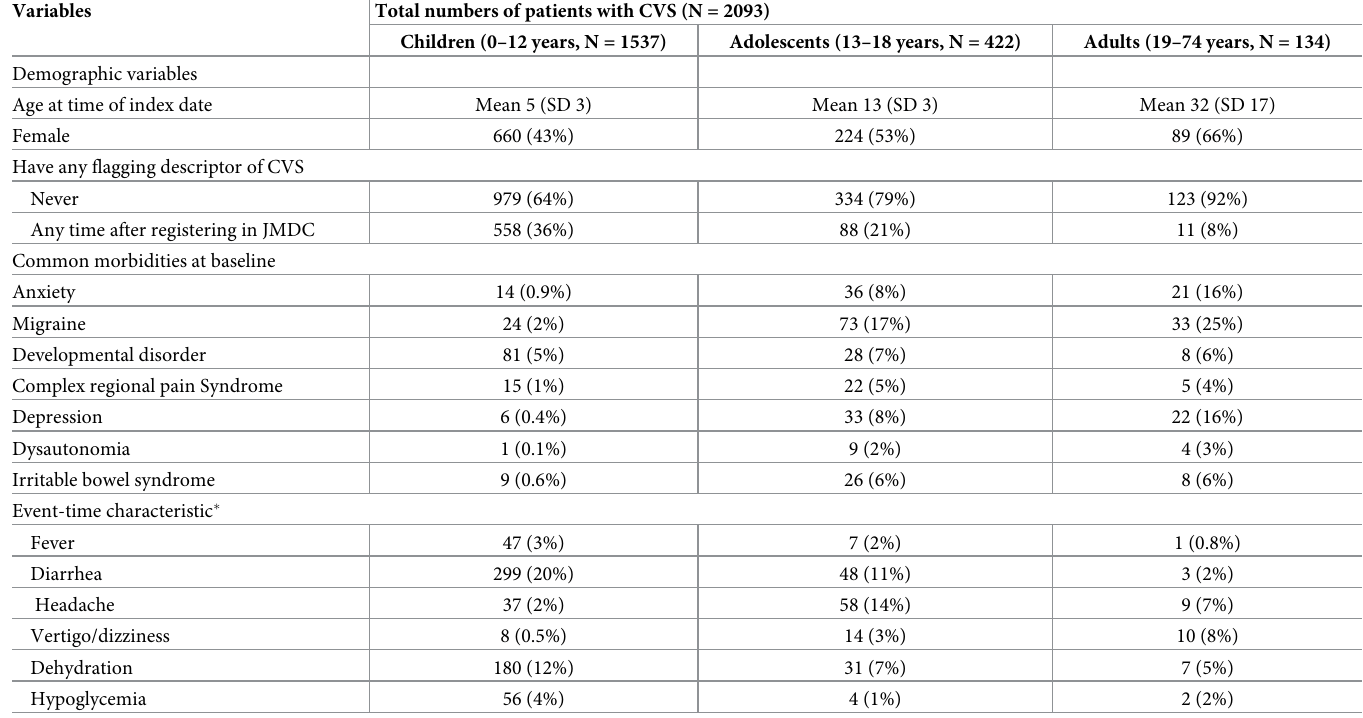
Table 1. Characteristics of identified CVS